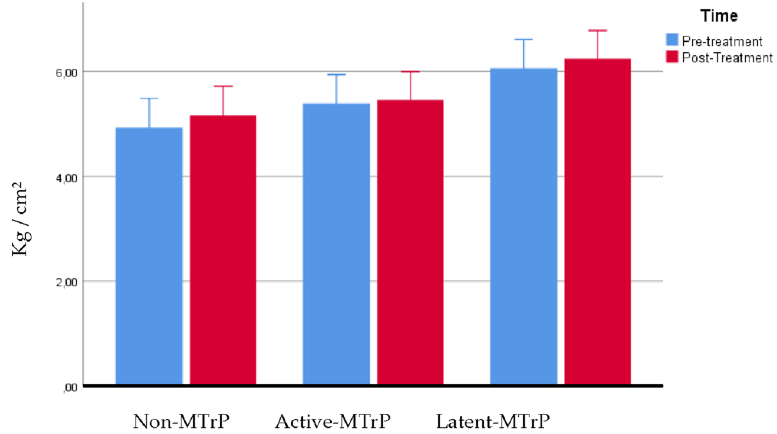
Figure 4. PPT over tibialis muscle.